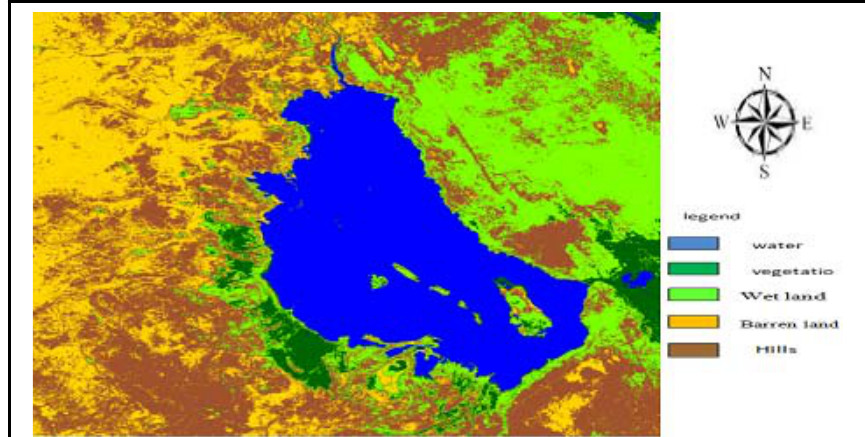
Fig.12: Unsupervised classification using K-Means classification method for Landsat-7